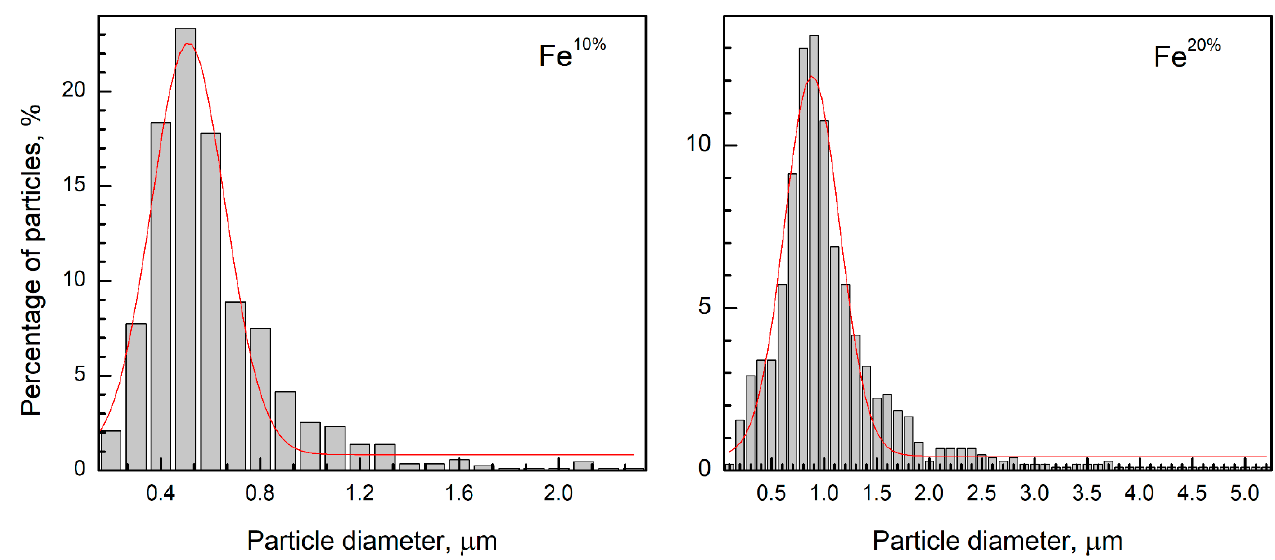
Figure 3. Particle size distribution, measured from the SEM images, of the Fe 10% and Fe 20% powders, where red line is Gaussian function.